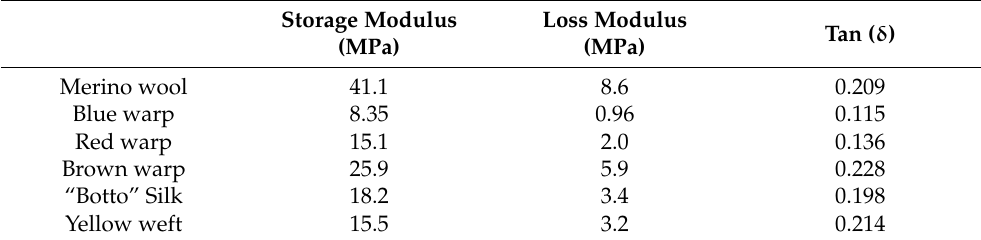
Table 2. Rheological properties at 25 ◦ C of commercial merino wool, Botto silk and Sixteenth Century